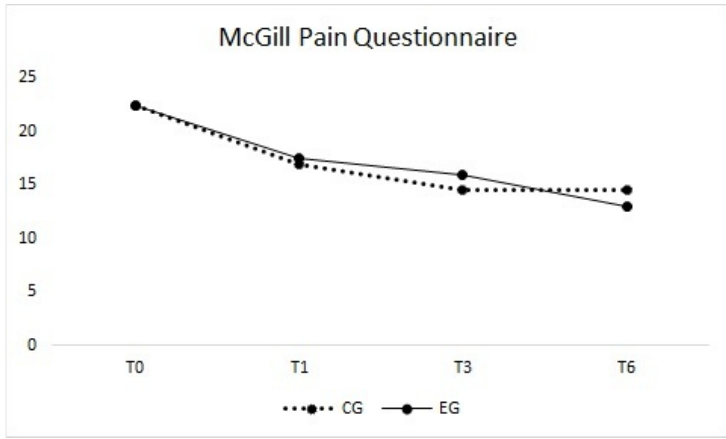
Figure 4. Trend of McGill Pain Questionnaire median scores over time.